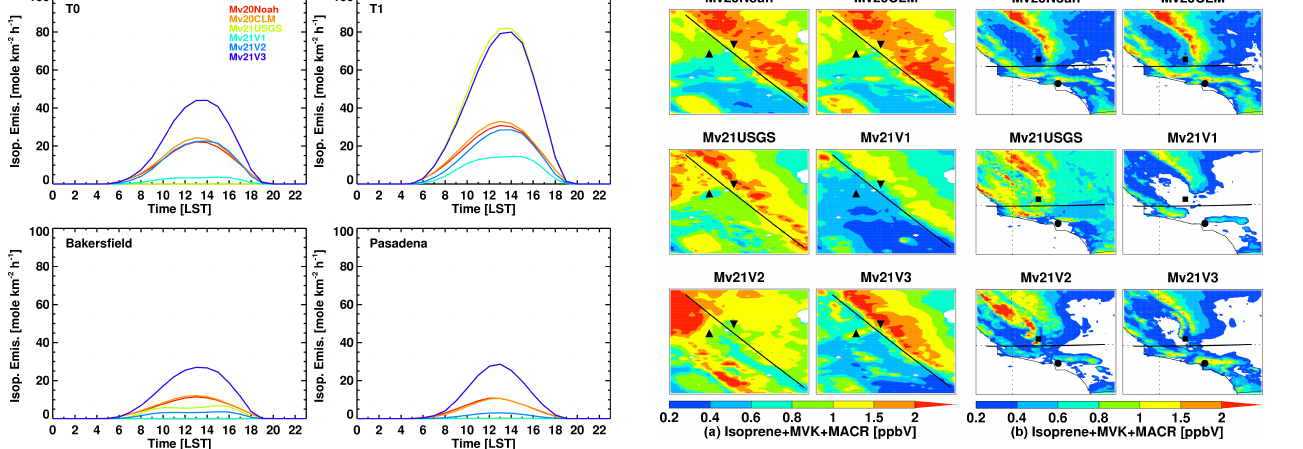
Figure 10. Average diurnal variation of biogenic isoprene emissions at the four observation sites from the six simulations listed in Ta- ble 1.